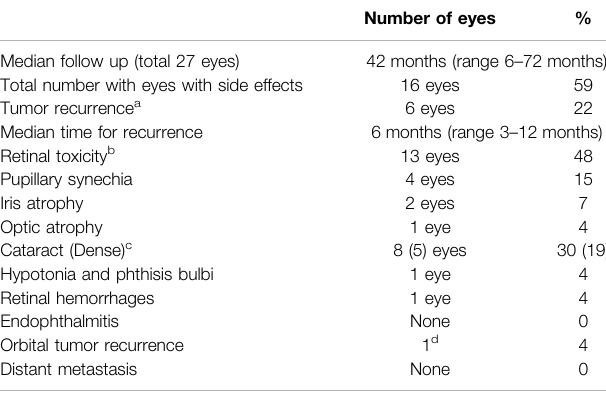
TABLE 3 | Side effects of intravitreal melphalan